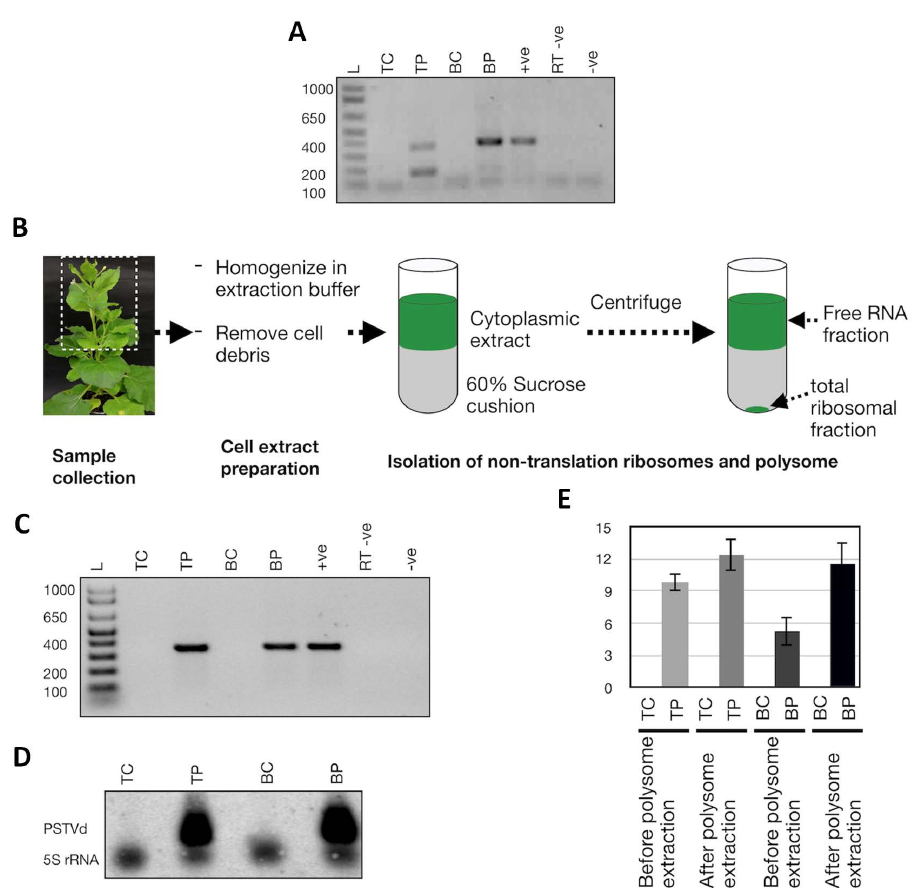
Figure 3. Detection of ribosome-associated PSTVd in host plants. Both Tomato cv. Rutgers and N. benthamiana plants were inoculated with PSTVd RG1 . ( A ) Total RNA extracted and RT-PCR